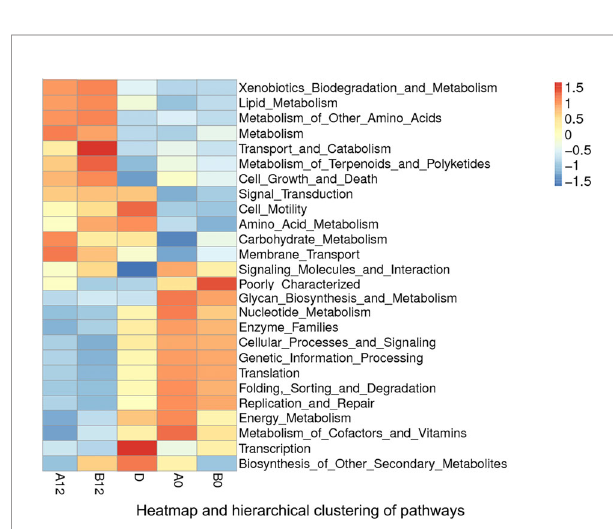
FIGURE 6 | Heatmap and hierarchical clustering of pathways in A0, B0, D, A12 and B12 groups. A0, people living with acute HIV infection at baseline; B0, people living with chronic HIV infection at baseline; D, HIV-uninfected controls; A12, people living with acute HIV infection after 12 weeks of ART; B12, people living with chronic HIV infection after 12 weeks of